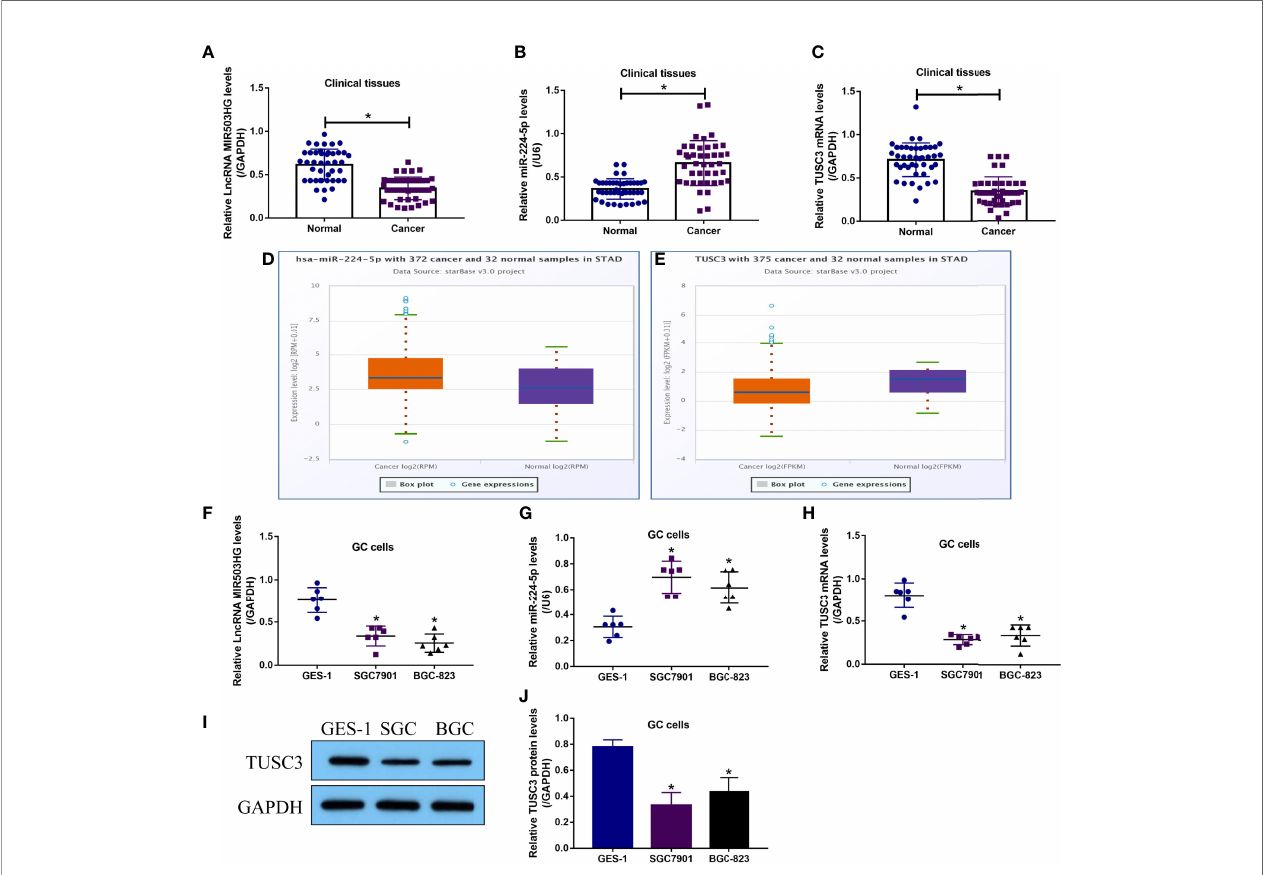
FIGURE 1 | LncRNA MIR503HG, miR-224-5p and TUSC3 were aberrantly expressed in GC tissues and cells. The expression levels of (A) LncRNA MIR503HG, (B) miR- 224-5p and (C) TUSC3 mRNA in GC tissues were examined by using the Real-Time qPCR analysis. Pan-cancer analysis was performed to analyze the expressions of (D) miR-224-5p and (E) TUSC3 in the normal and cancer tissues of STAD patients. The expression status of (F) LncRNA MIR503HG, (G) miR-224-5p, and TUSC3 (H) mRNA and (I, J) protein were analyzed by Real-Time qPCR and Western Blot, respectively. Each experiment contained 3 repetitions, and P < 0.05 were marked by “ * ”